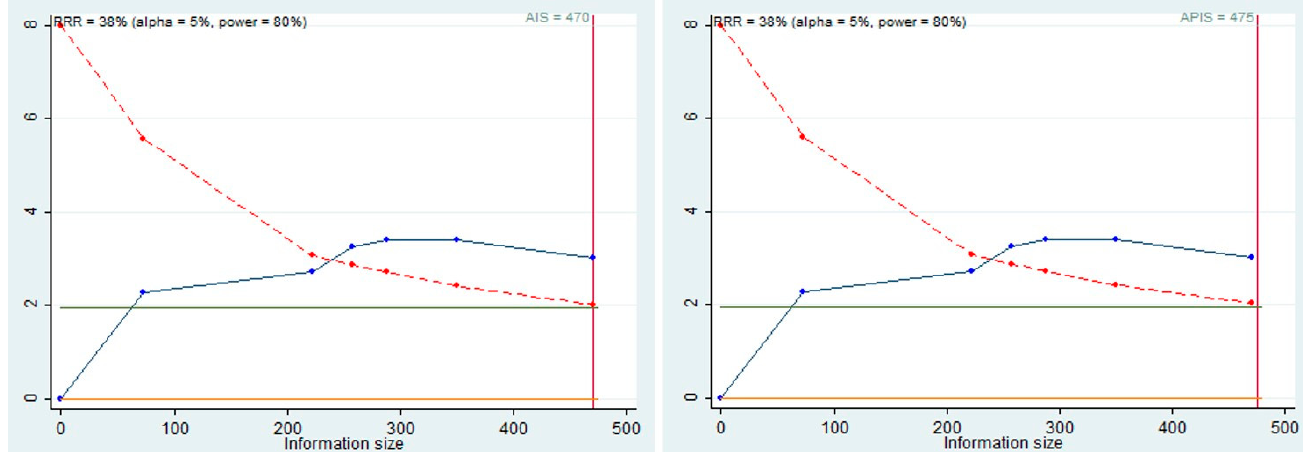
Figure 8. AIS, APIS, light green line (Z = 1.98), dashed red line (monitoring boundary), blue line (cumulative z curve), red line (sample size).